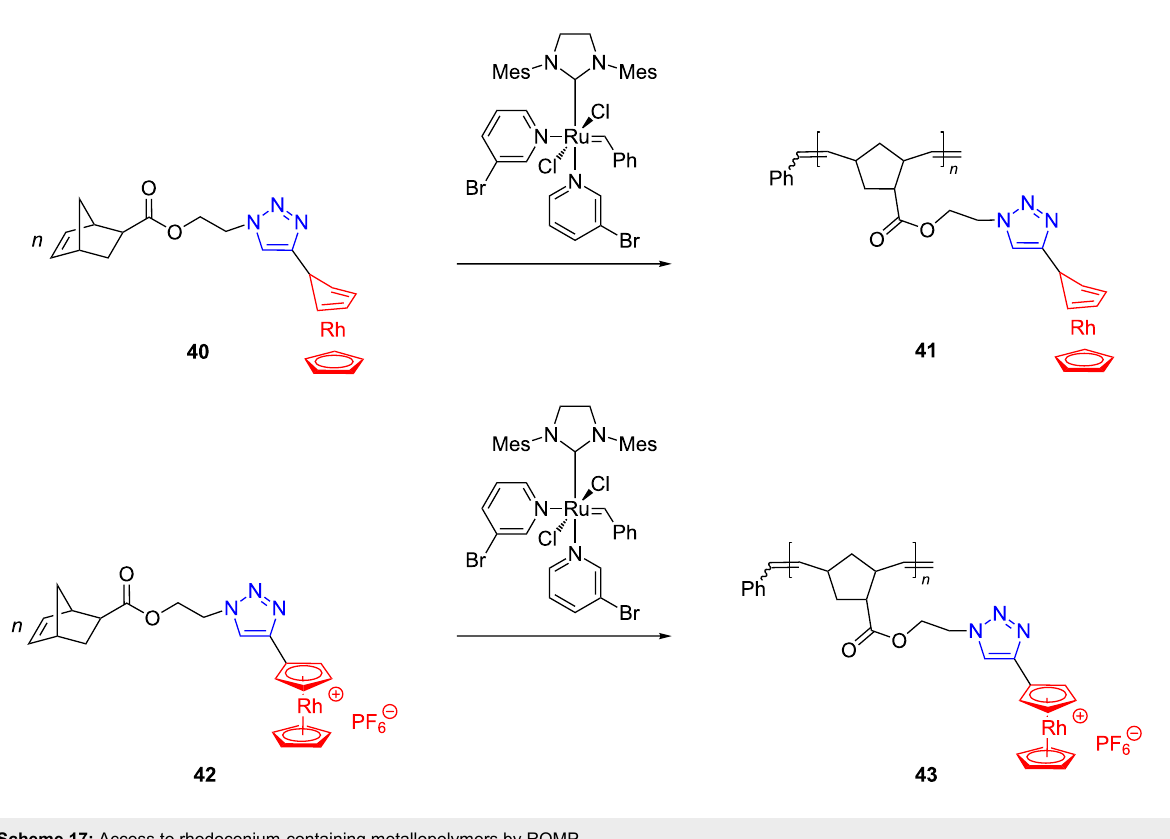
Scheme 17: Access to rhodocenium-containing metallopolymers by